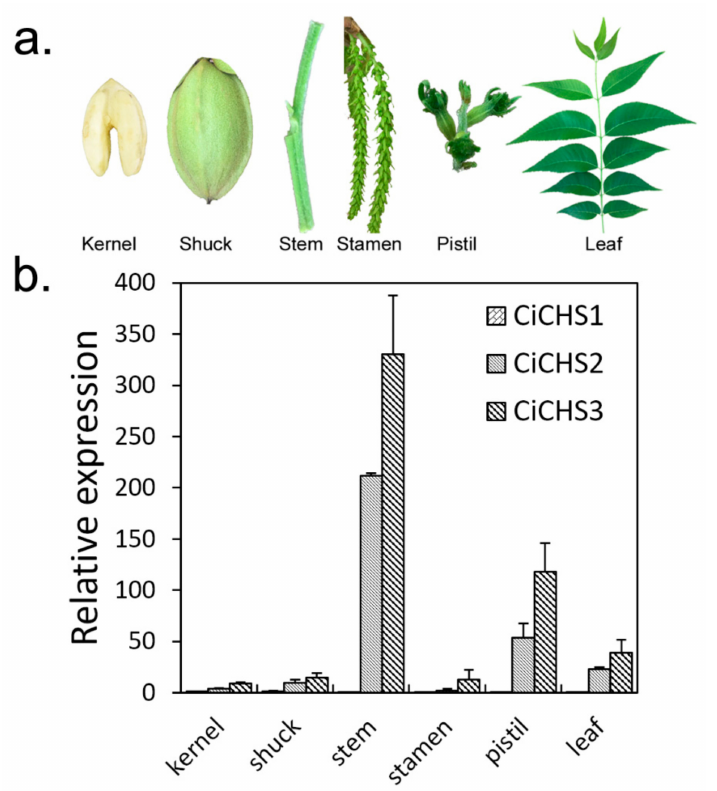
Figure 4. Six types of tissue ( a ), and the expression patterns of the three CiCHSs in the six di ff erent tissues ( b ). Each reaction was performed in three biological replicates, and the data are presented as the mean ± standard error